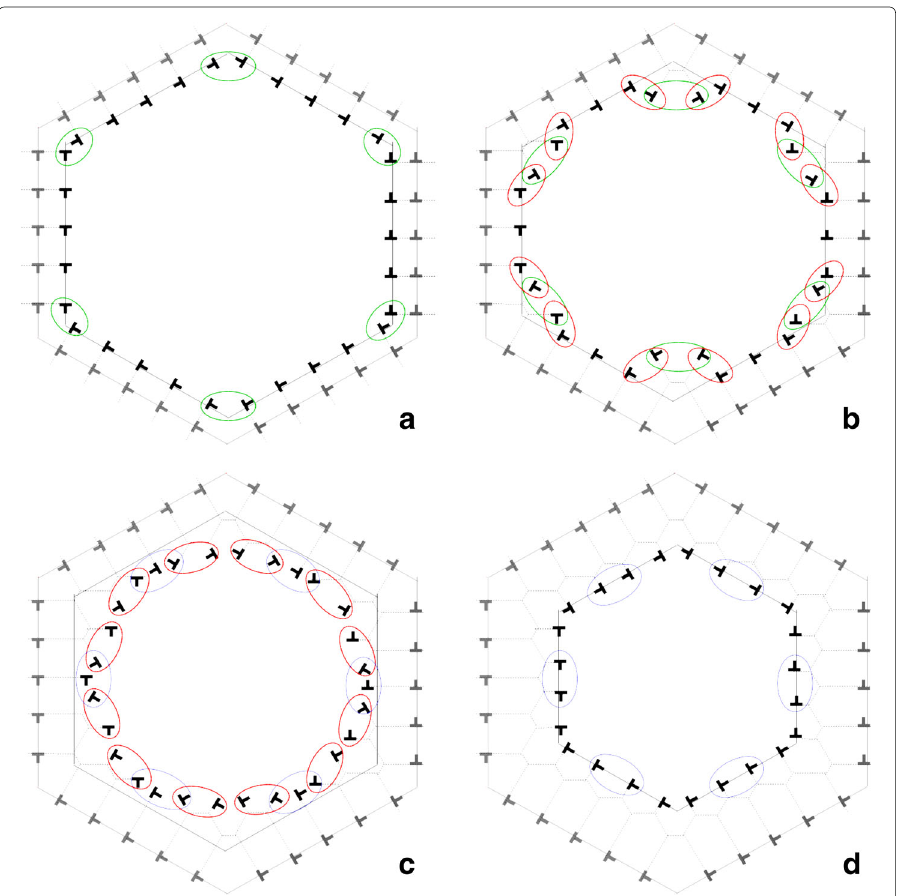
Fig. 10 Simplified model proposed to explain the boundary migration by progressive cellular rings: a ) simple glide of dislocations; b ) an unstable situation is reached at the corners when dislocations with Burgers vectors rotated by 60 ◦ approach one to the other and proceed to an effective climb mechanism. Pairs of dislocations that undergo this climb process are highlighted by green circles just before -in a )- and just after -in b )- the climb process; c ) the dislocations at the corners propagate along the sides by a chain of effective climb events, see red circles in b ) and corresponding red circles in c ); d ) a cellular hexagonal-shaped ring is closed and the dislocation number per side is lowered through a three-to-two annihilation reaction, see blue circles in c ) and d